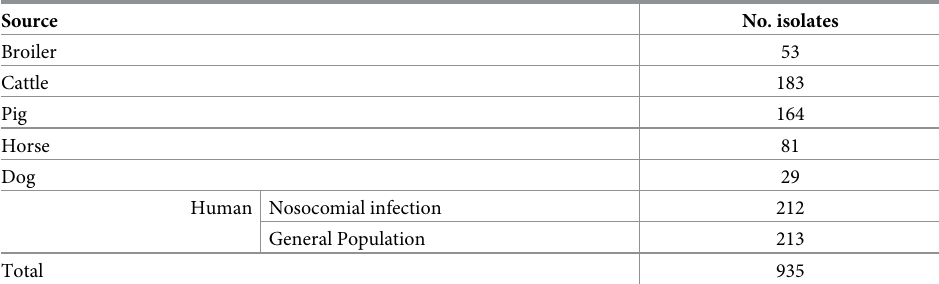
Table 1. Number of ESBL-producing E . coli isolates (n = 935) used in the modelling